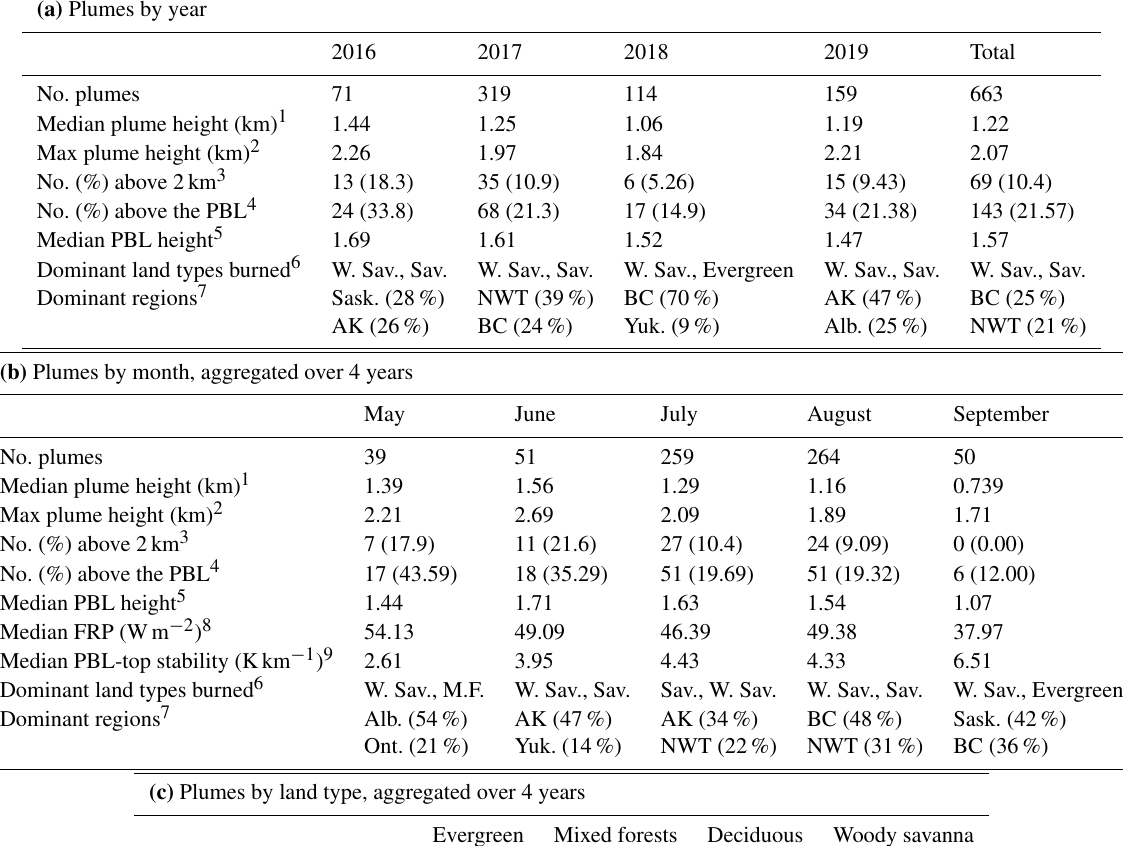
Table 2. Distributions of plume number, plume height, boundary layer height, location of burn, and dominant MODIS fuel type shown in three different ways: (a) annually, (b) monthly, and (c) by fuel type. Note that an individual fire may burn in several biomes, so plumes in Table 2c are not in mutually exclusive categories. PBL denotes planetary boundary layer. See footnotes for land type and region/territory